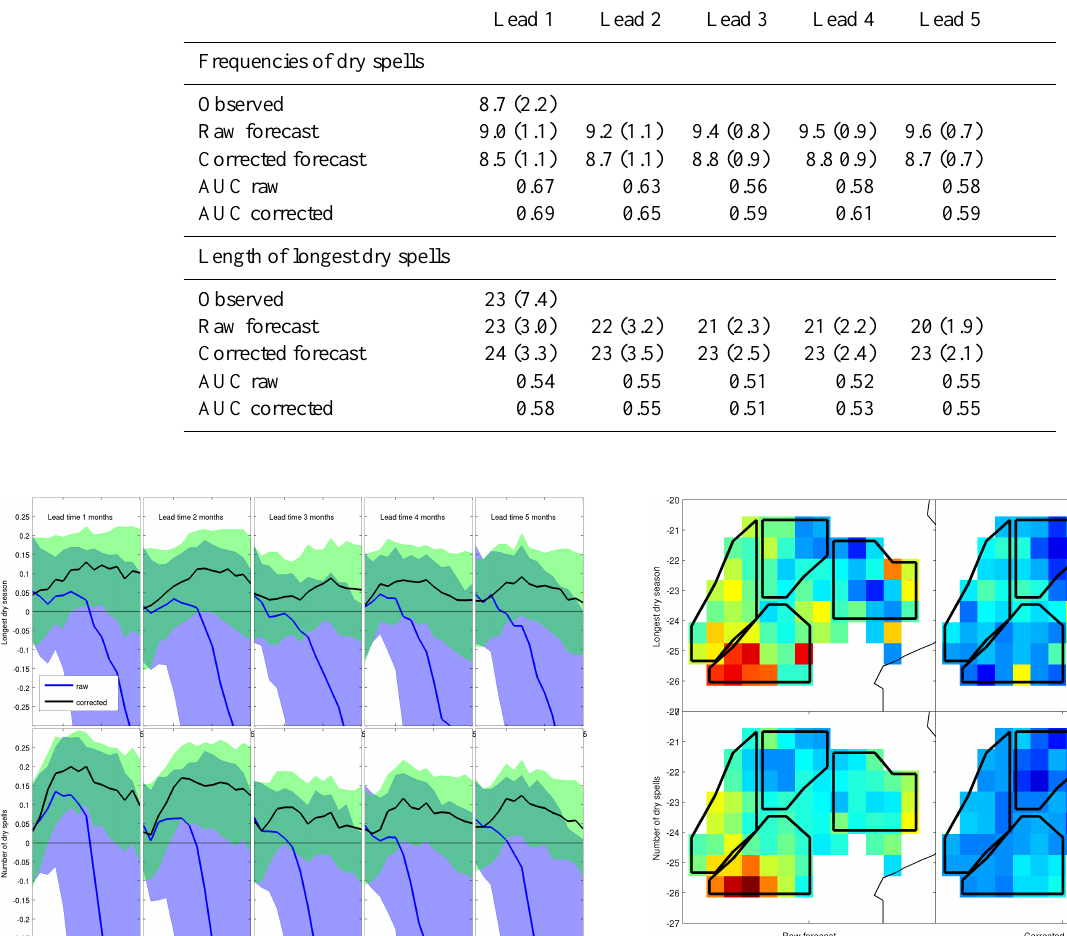
Table 1. Length of dry spells and frequency of dry spells from the EGCP data (observed) and forecasted with raw forecast and bias corrected. The results are with a 5mm threshold applied and averaged over all points and years, and all ensemble members for the forecast. The standard deviation is shown in brackets.